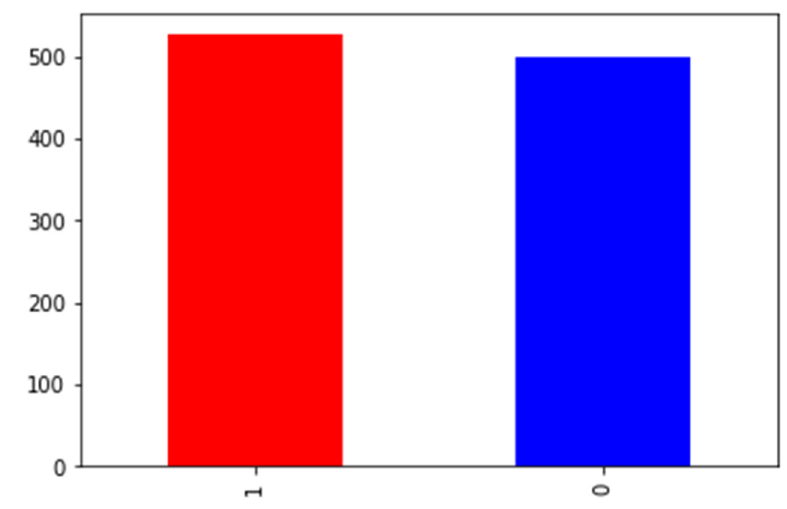
Figure 3. Target Outcome in the Heart Dataset